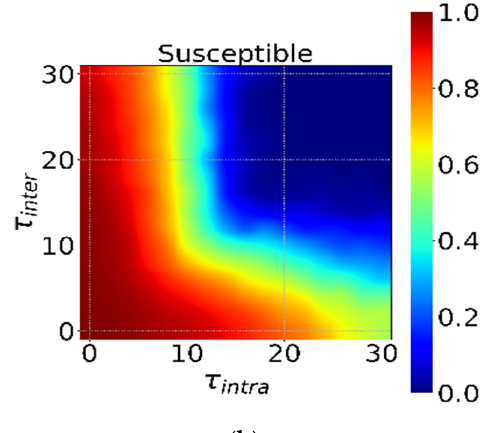
Figure 6. The interaction effect of the (cid:2030) (cid:3036)(cid:3041)(cid:3047)(cid:3045)(cid:3028) and (cid:2030) (cid:3036)(cid:3041)(cid:3047)(cid:3032)(cid:3045) under (cid:2028) (cid:3036)(cid:3041)(cid:3047)(cid:3045)(cid:3028) = (cid:2028) (cid:3036)(cid:3041)(cid:3047)(cid:3032)(cid:3045) = 0 . The horizontal axis is (cid:2030) (cid:3036)(cid:3041)(cid:3047)(cid:3045)(cid:3028) , and the vertical axis is (cid:2030) (cid:3036)(cid:3041)(cid:3047)(cid:3032)(cid:3045) in ( a – f ). Different colors in the heatmap indicate different S . The ratio from dark red to dark blue transitions from 1 to 0 in turn. ( a – f ) show the different incubation periods (cid:1831) (cid:3047) ( (cid:1831) (cid:3047) = 0, 5, 10, 15, 20, 25).